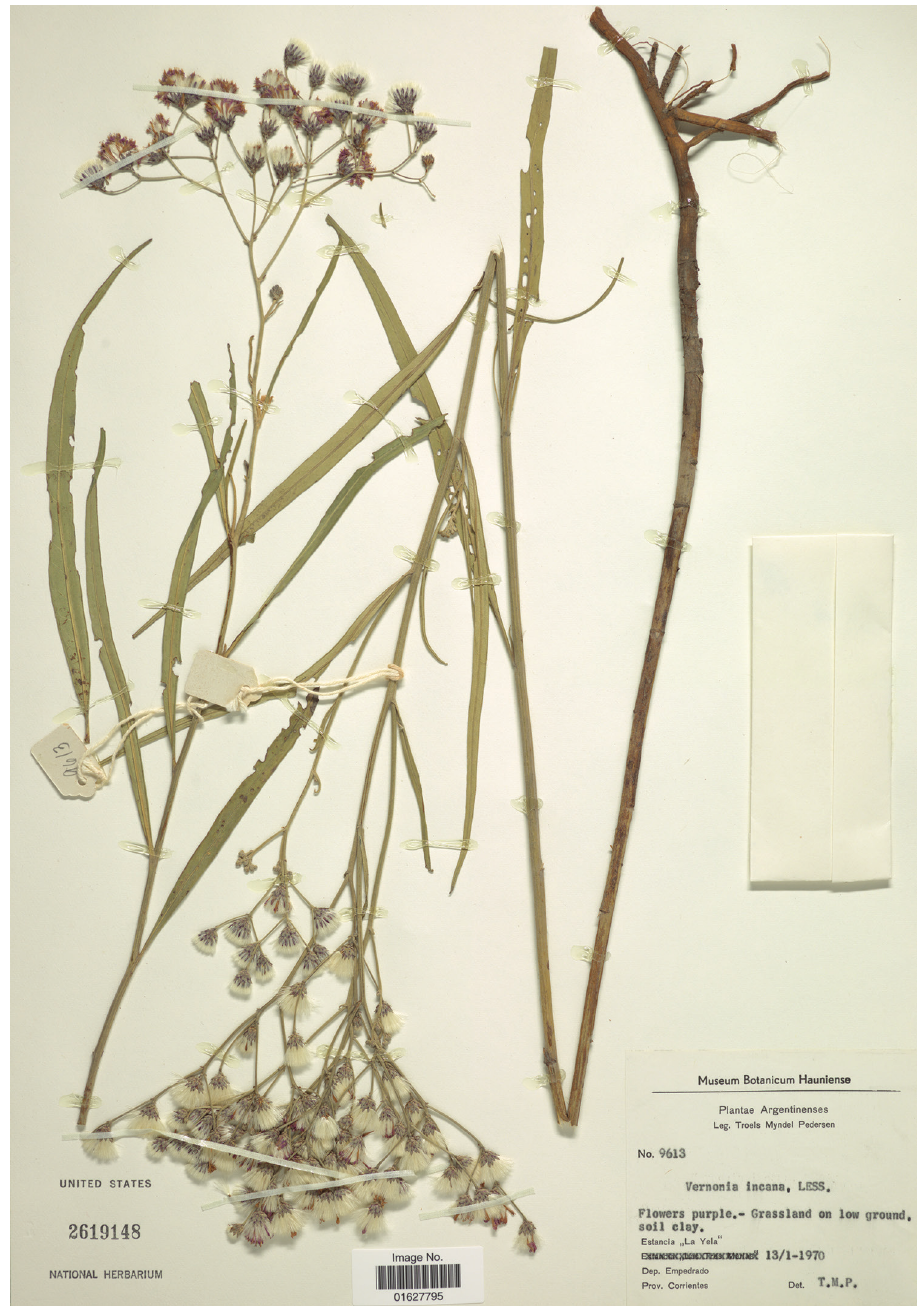
Figure 3. Image of US herbarium sheet of Vernonia incana Less. which shows the two types of roots: fleshy and fibrous. [photo courtesy of I. Lin,